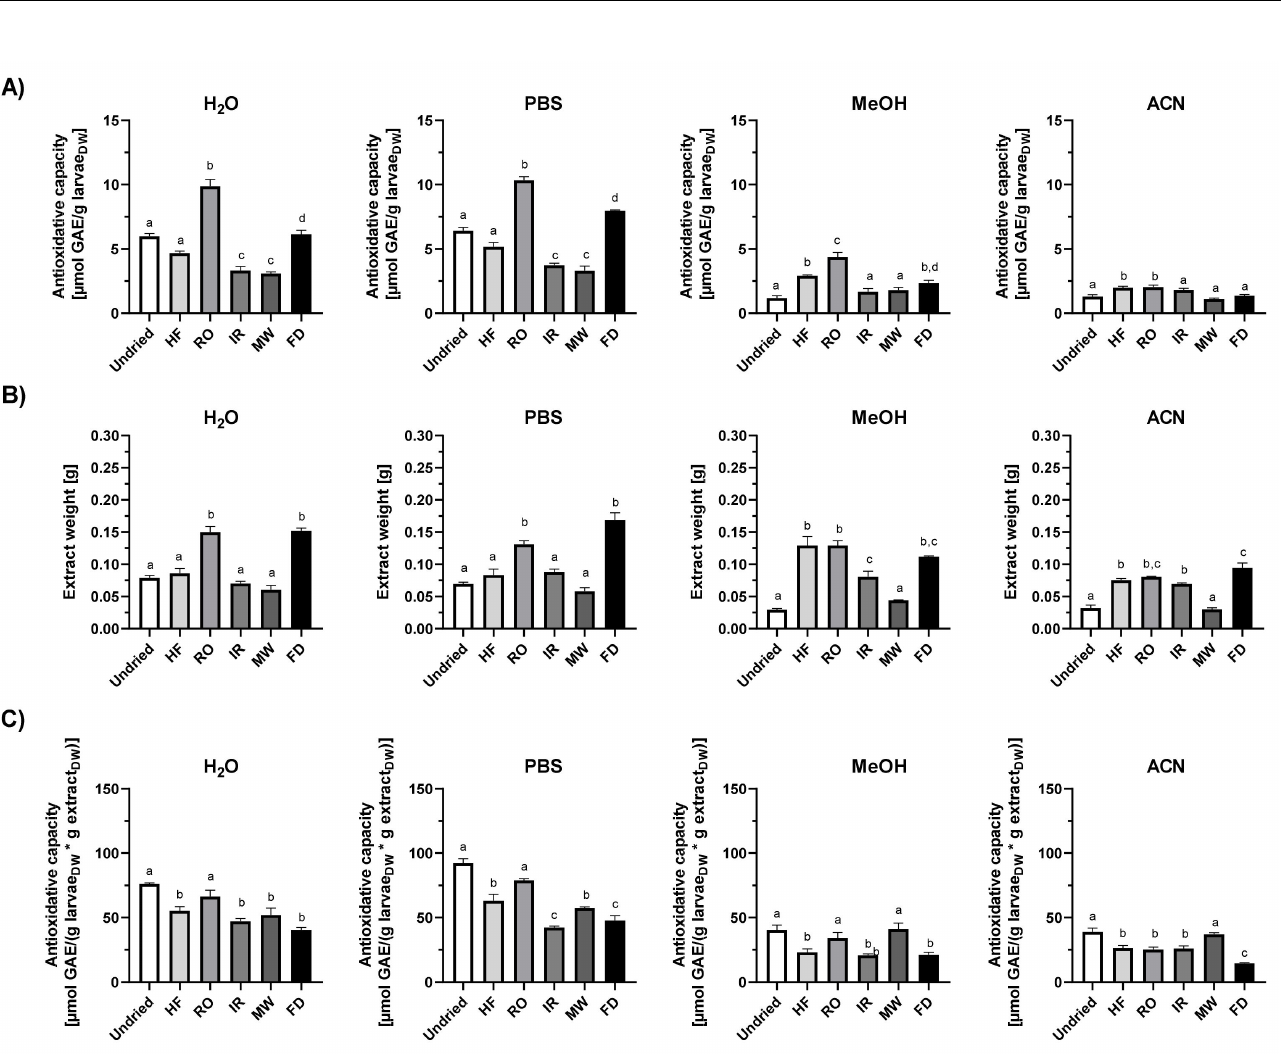
Figure 3. Folin–Ciocalteu reducing capacity of T. molitor larvae extracts. Antioxidant capacity of H 2 O, PBS, methanol and acetonitrile mealworm extracts measured by reduction of Folin–Ciocalteu reagent and normalized to ( A ) the larval dry weight or ( C ) the larval dry weight per extract dry weight. ( B ) Dry weight of extracts obtained from 0.5 g larval material each as a measure of extraction efficiency. Data are shown as means ± SEM of three replicates. Significantly different means within one panel do not share the same letters (analysed by one-way ANOVA with Tukey’s multiple comparison test, p < 0.05). DW= dry weight, GAE = Gallic acid equivalent. DW= dry weight, TE = Trolox equivalents. HF = high-frequency dried, RO = rack oven-dried, IR = infrared dried, MW = microwave dried, FD =